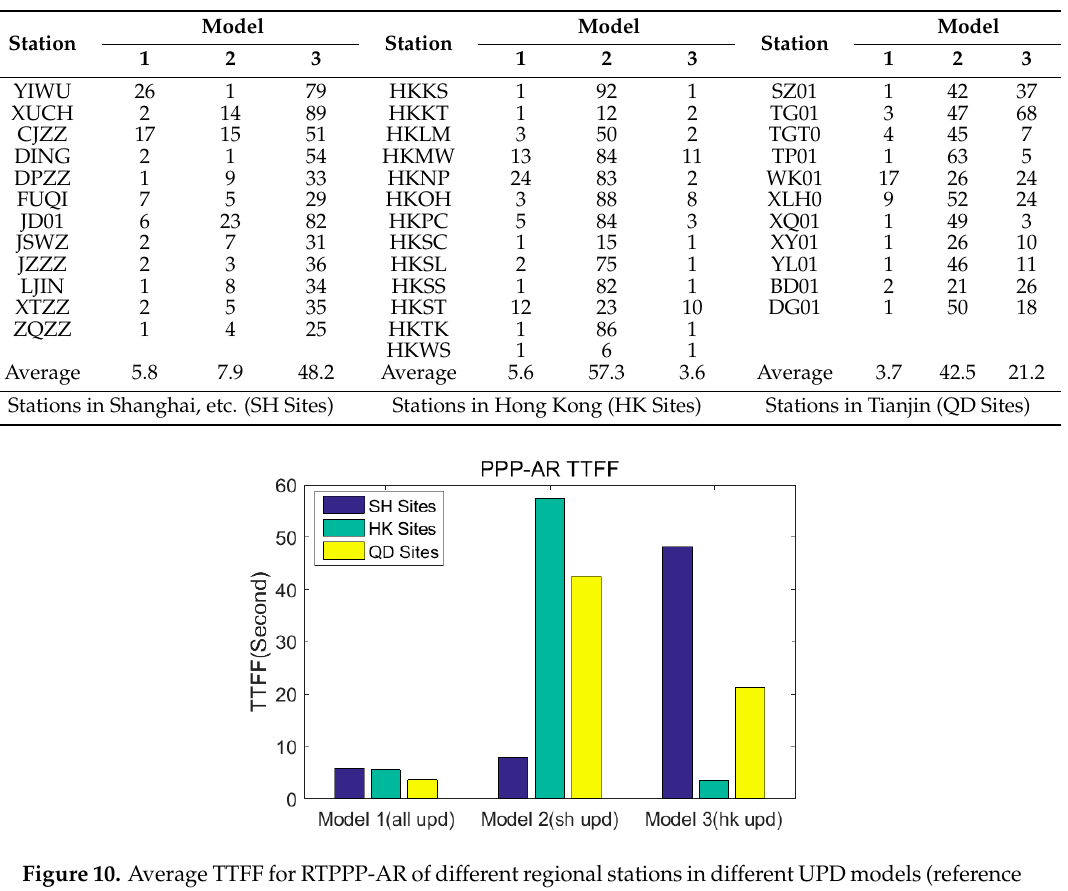
Table 5. TTFF for RTPPP-AR of different regional stations in different UPD models (reference station coordinates are set to known).